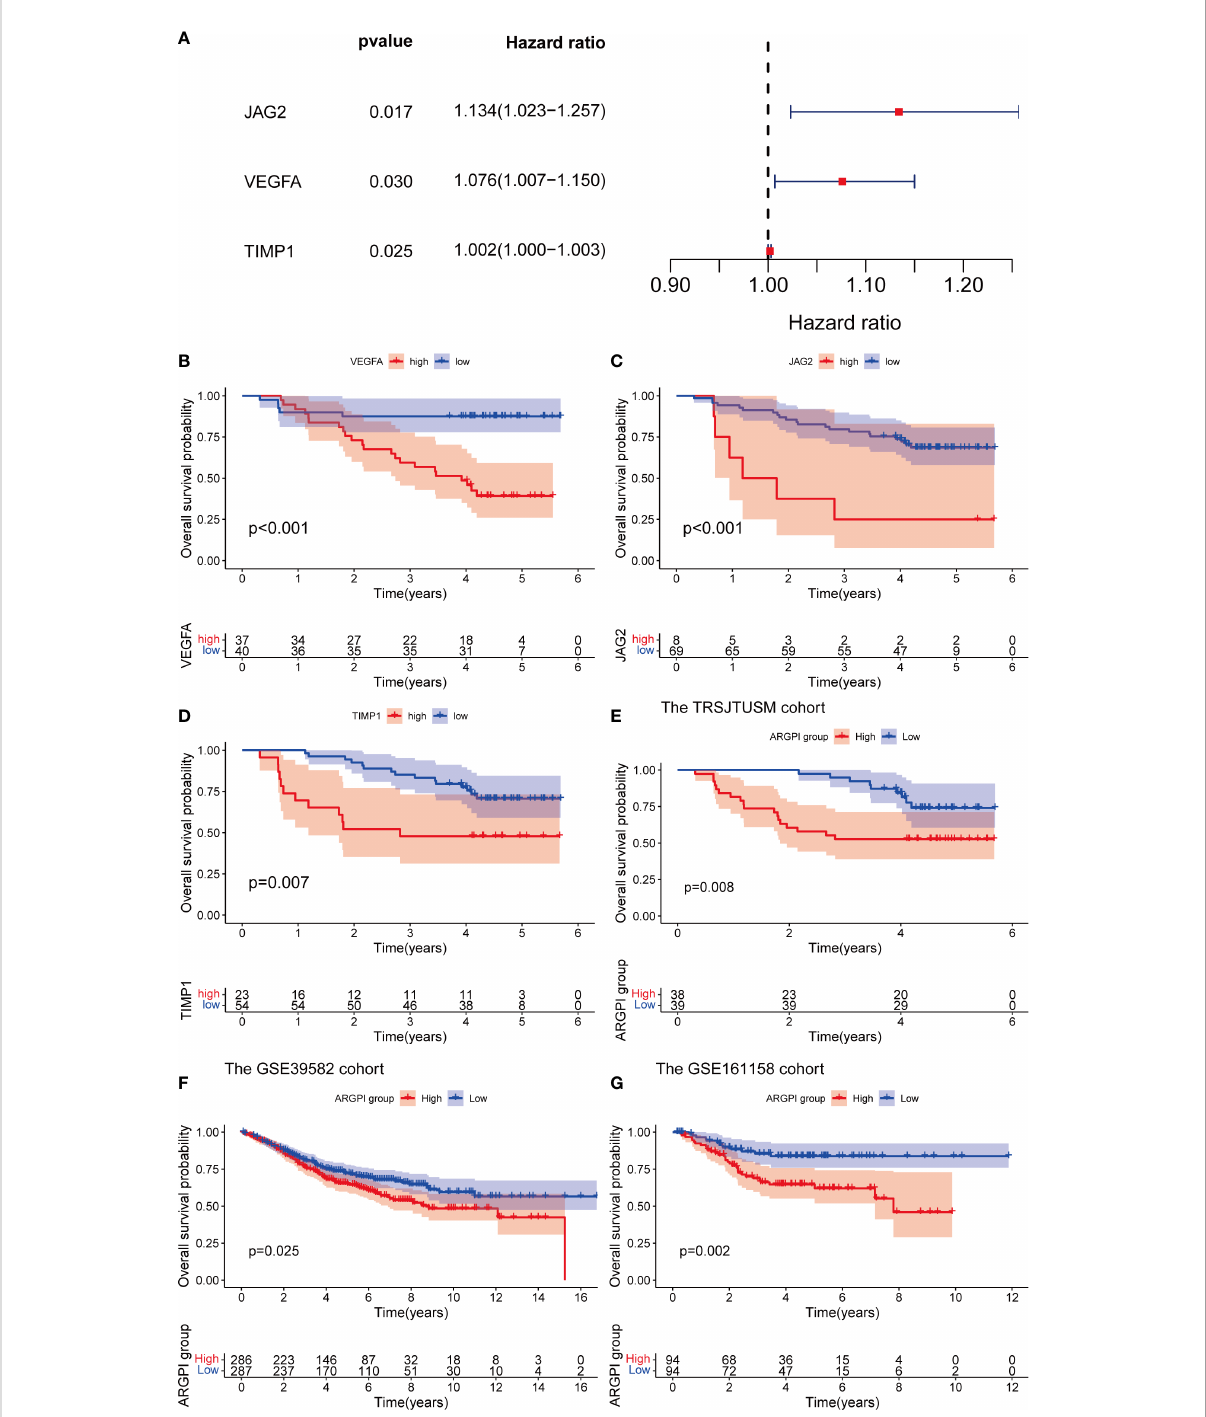
FIGURE 2 Veri fi cation of ARGPI. (A) Univariate Cox Analysis of JAG2, VEGFA and TIMP1 in TRSJTUSM Cohort. (B – D) Kaplan-Meier survival analysis of JAG2, VEGFA and TIMP1 in TRSJTUSM Cohort. (E) Kaplan-Meier survival analysis of ARGPI subgroups in the TRSJTUSM cohort. (F) Kaplan-Meier survival analysis of ARGPI subgroups in the GSE39582 cohort. (G) Kaplan-Meier survival analysis of ARGPI subgroups in the GSE161158